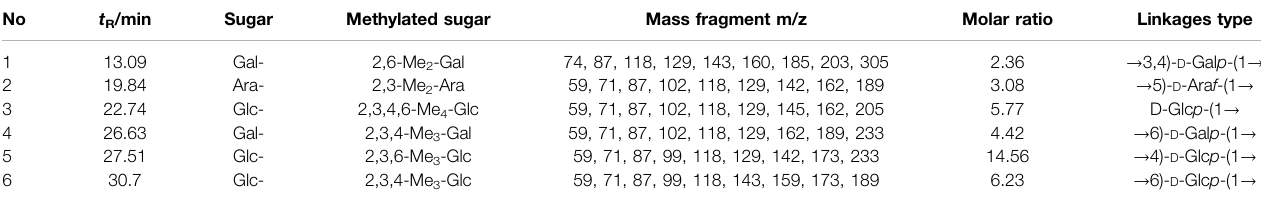
TABLE 3 | Analysis of APS-II methylation results.